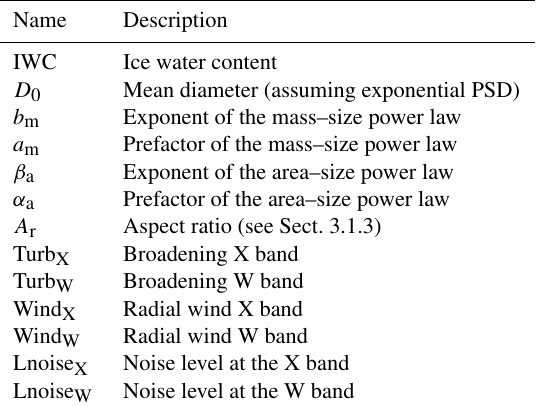
Table 1. Microphysical, atmospheric, and radar